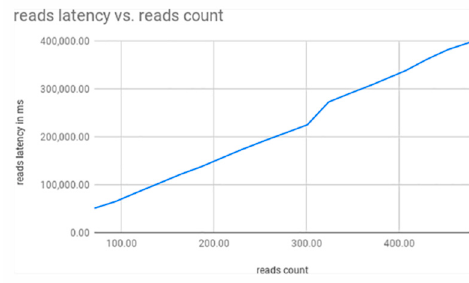
Figure 14. Reads latency curve versus the command operations count.